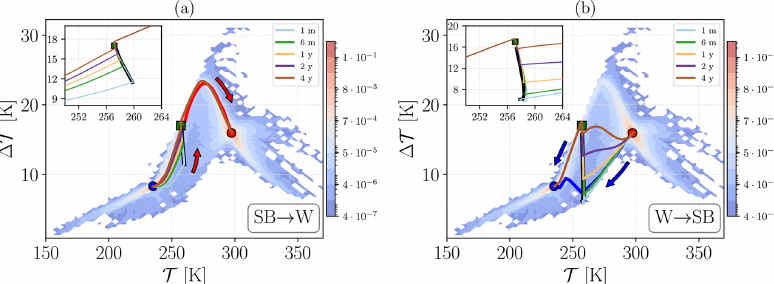
Figure C1. Comparison between the supercritical paths constructed using singular perturbations of different duration τ , where, in the legend, m stands for month and y stands for years. (a) SB → W transitions. (b) W → SB transitions. Different values of τ correspond to different coloured lines. The basin boundaries are now depicted as thick black lines. Here, α = 1 . 0 and (cid:15) = 0 . 004.